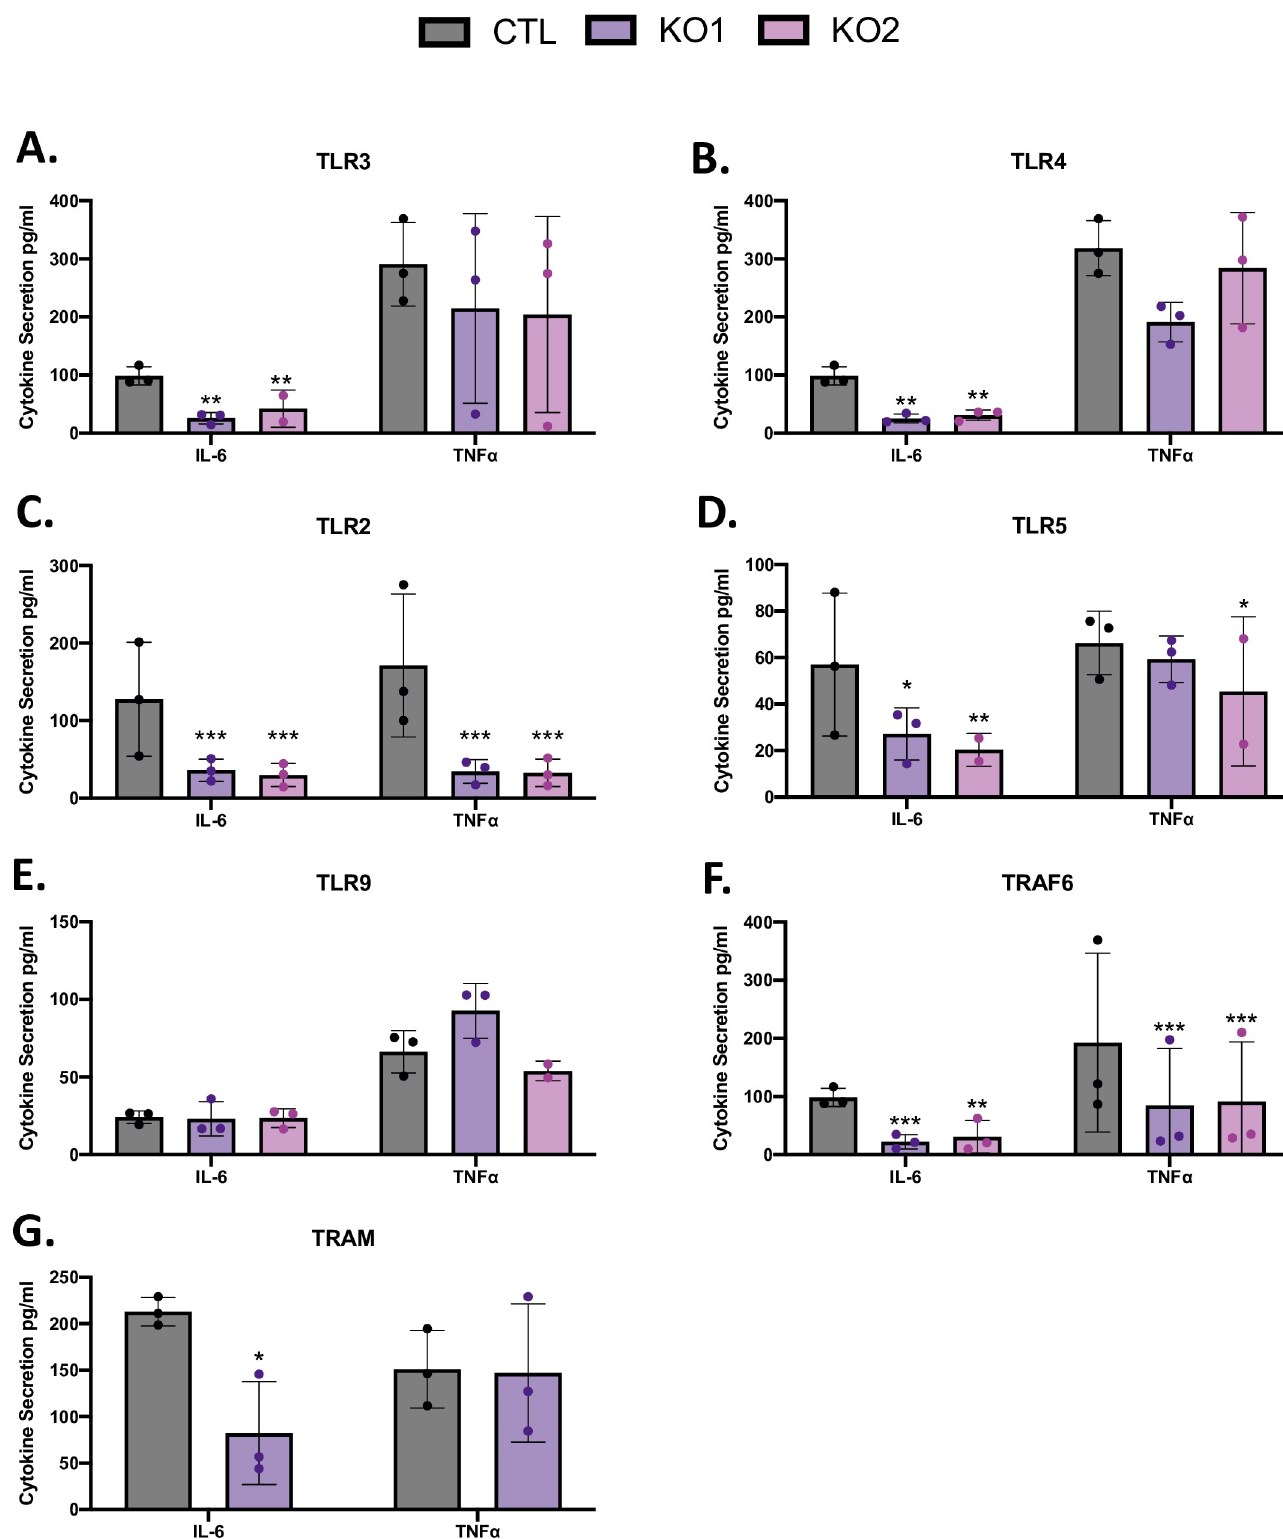
Fig 3. Effect of CRISPR/Cas9 KO of TLRs, TRAF6, and TRAM on cytokine production from human macrophages after infection with L . pneumophila . U937 cells expressing a non-targeting CRISPR guide plasmid (CTL, black bars) and independent clones of U937 cells containing a